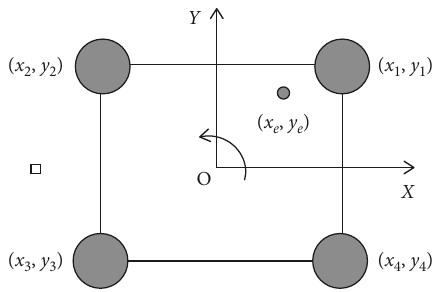
Figure 6: Floor coordinate